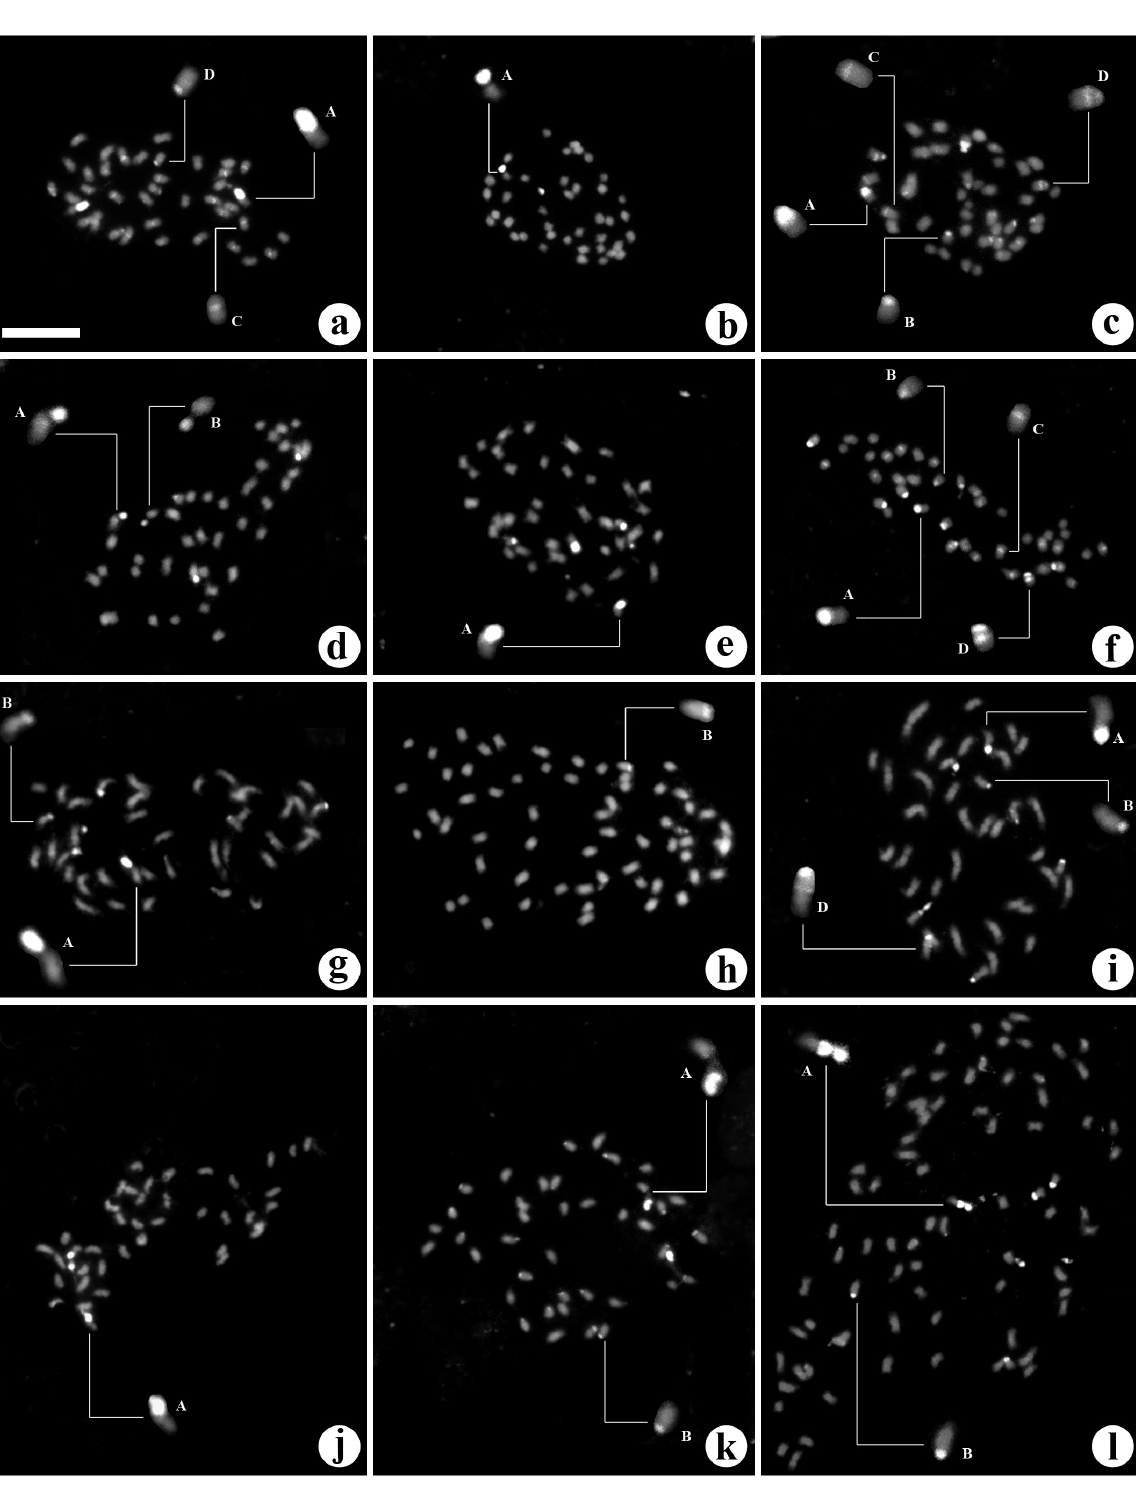
Figure 1 - Distribution of CMA + bands in Bignonieae (Bignoniaceae) species: a. Adenocalymma divaricatum , b. A. imperatoris- maximilianii , c. Amphilophium bauhinioides , d. A . crucigerum , e. A. elongatum , f. A . scabriusculum , g. Anemopaegma album , h. A. citrinum , i. A. leave , j. Cuspidaria laterifolia , k. Dolichandra quadrivalvis , l. D . unguis-cati . Scale bar in a corresponds to 10